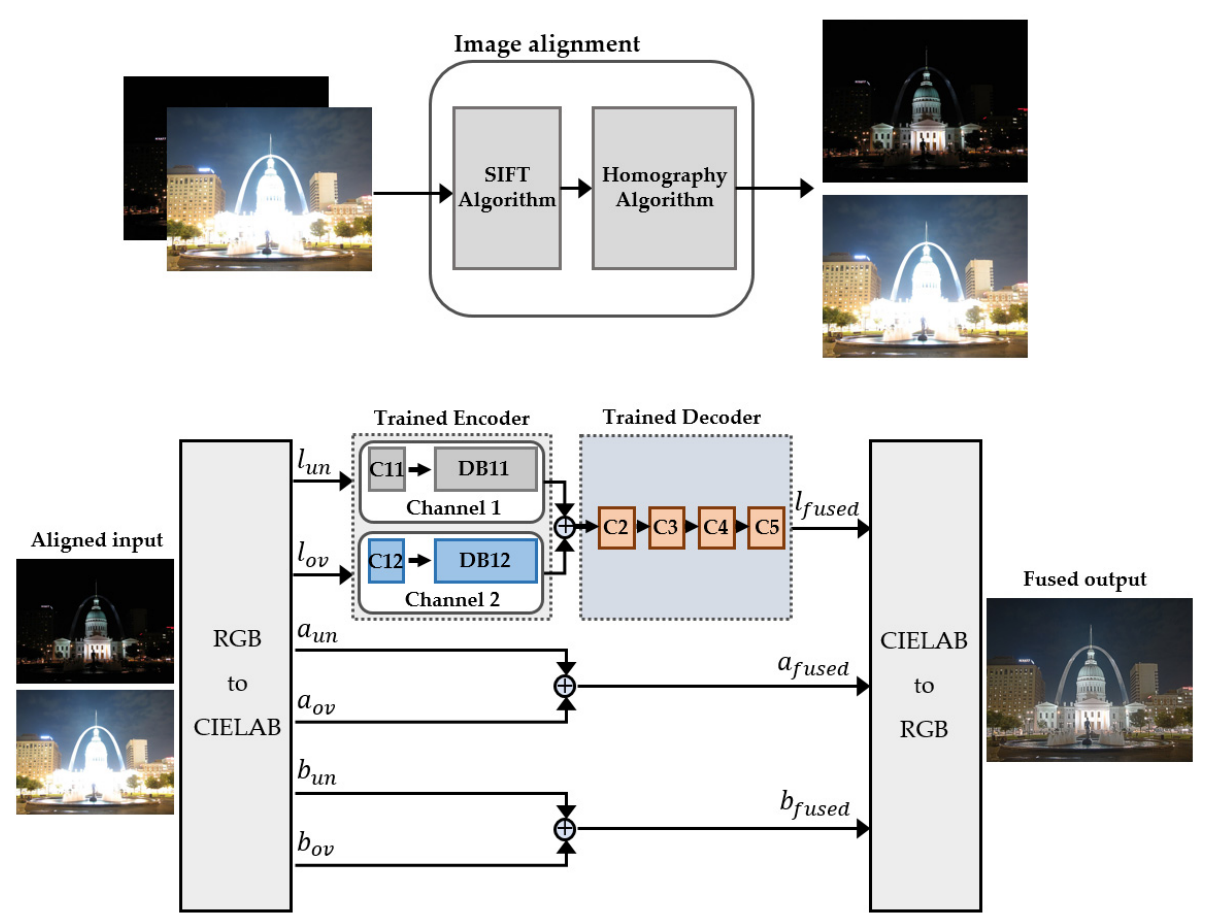
Figure 9. Image fusion scheme of the proposed model. After aligning the LDR images, the color space of the images was converted from RGB to CIELAB. Because CIELAB has excellent color separation based on human vision, it preserves the color components of each input image. In Figure 9, l un and l ov denote the luminance channels of the under-exposed and over-exposed images, respectively. C11, C12, C2, C3, C4, and C5 are the trained ConvLayers. DB11 and DB12 are the trained DenseBlocks. l fused is determined from l un and l ov by trained neural networks; a fused and b fused are simply calculated by adding half of a un and a ov or b un and b ov , which are the color obtained by converting the color space into an RGB